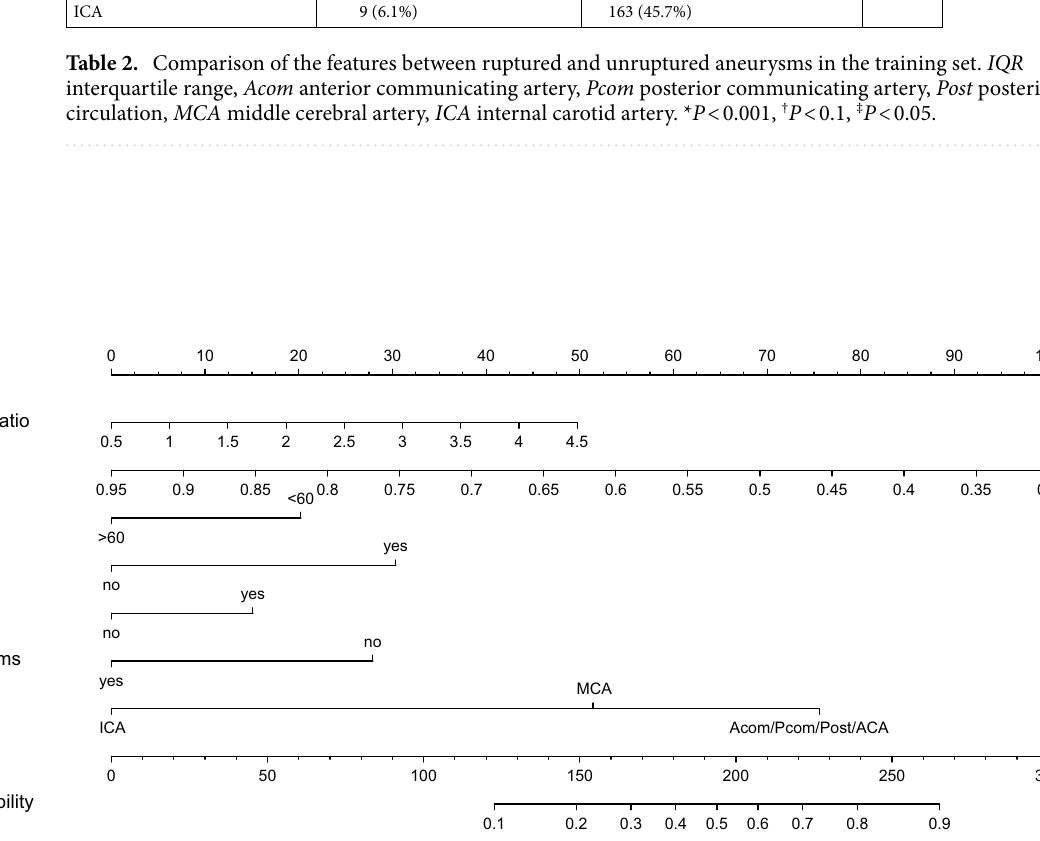
Figure 1. Nomogram for predicting aneurysm rupture risk. To calculate the rupture risk of an aneurysm, first determine the value for each feature by drawing a vertical line from that feature to the points scale. Then sum up all the individual values and draw a vertical line from the total points scale to the probability at the Diagnostic Probability line to obtain the rupture risk